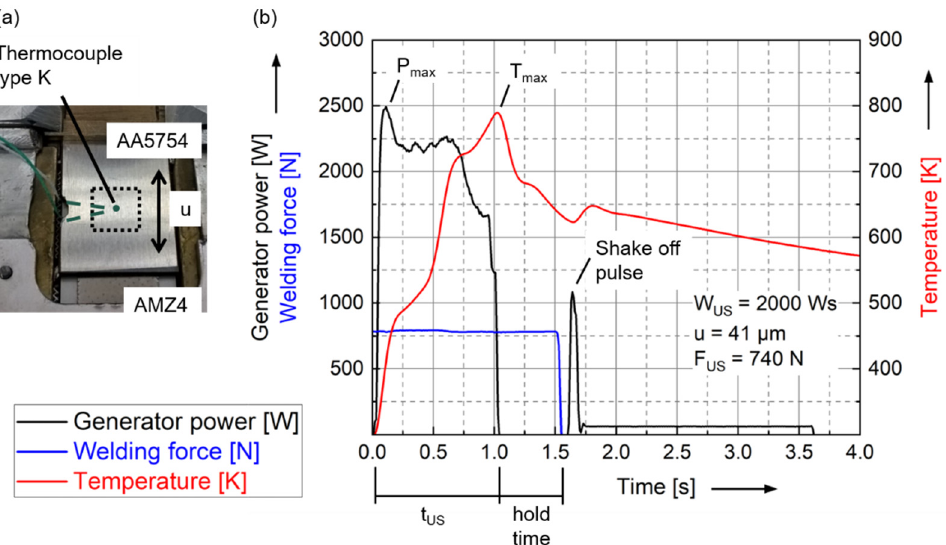
Figure 6. ( a ) Schematic illustration of the position of the thermocouple for temperature measurement at the interface in the center of the weld spot. ( b ) Characteristic curves of generator power, welding force and temperature measured with the thermocouple over time for AA5754/AMZ4 joints. The maximum temperature T max at the weld spot of 807 ± 25 K is reached at the end of the welding time t US of 0.96 ± 0.06 s.